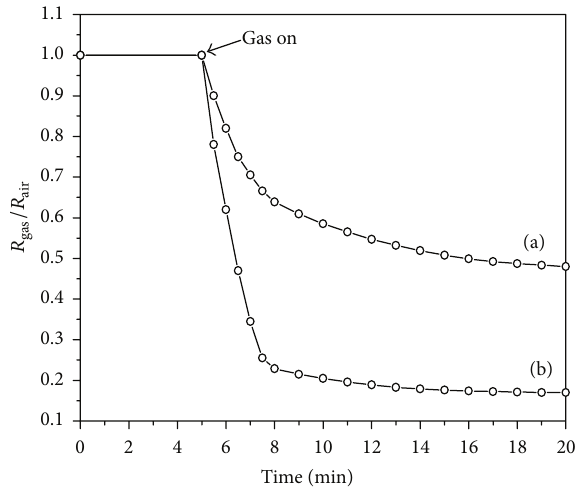
Figure 6: Sensing characteristics in presence of 1.6vol% LPG in air at 325 ∘ C for (a) undoped ZnO and (b) 1% AZO